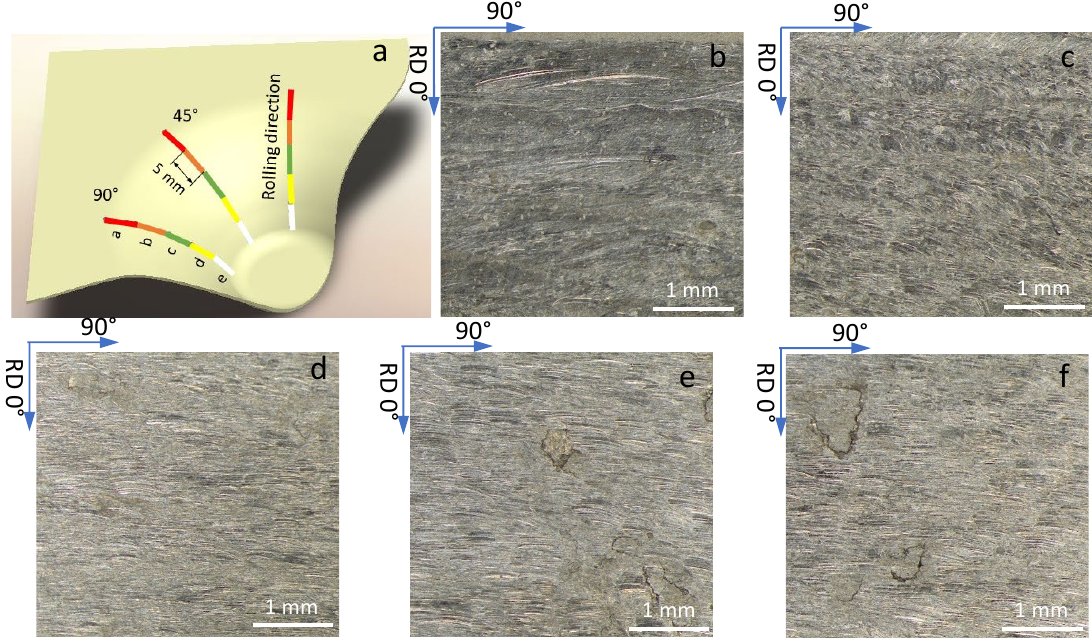
Figure 2. ( a ) Images corresponding to Part 5 (experiment 5) in the rolling direction at different depths; ( b – f ) correspond to Zones 1 to 5, respectively. The rolling direction, RD, corresponds to the vertical axis of the photographs.